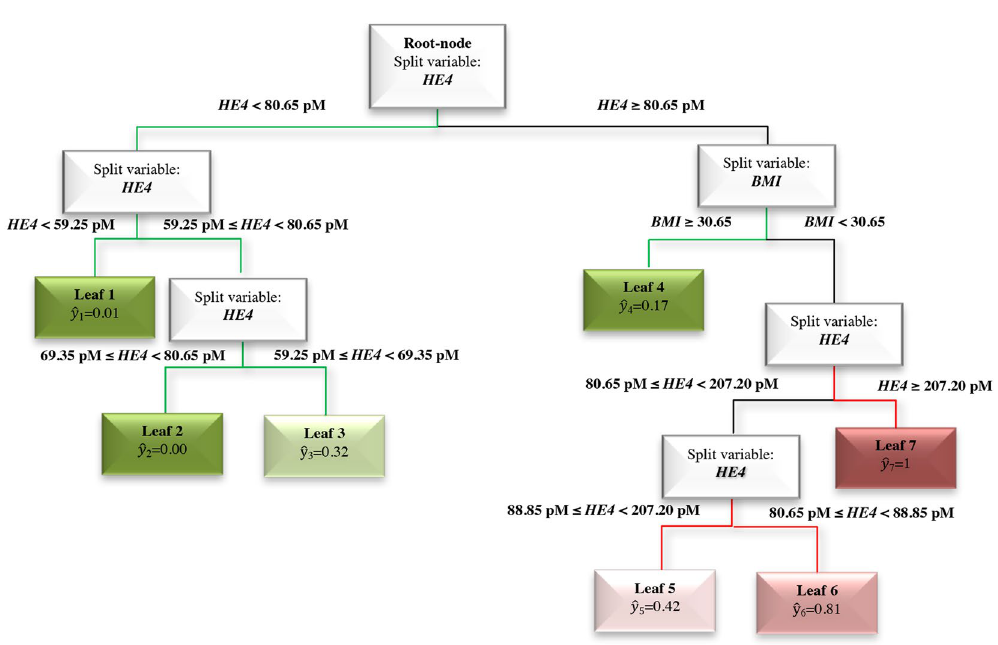
Figure 4. RERT obtained on the the subgroup of 219 endometrioid EC patients preoperatively classified as early stage (clinical stage). In detail, ŷ is the relative frequency of patients, clustered within the same final node, having an advanced surgical stage (FIGO stage > I). Low or high values of ŷ can be interpreted as low (paths highlighted in green) or high (paths highlighted in red) probability of having a surgical FIGO stage > I,